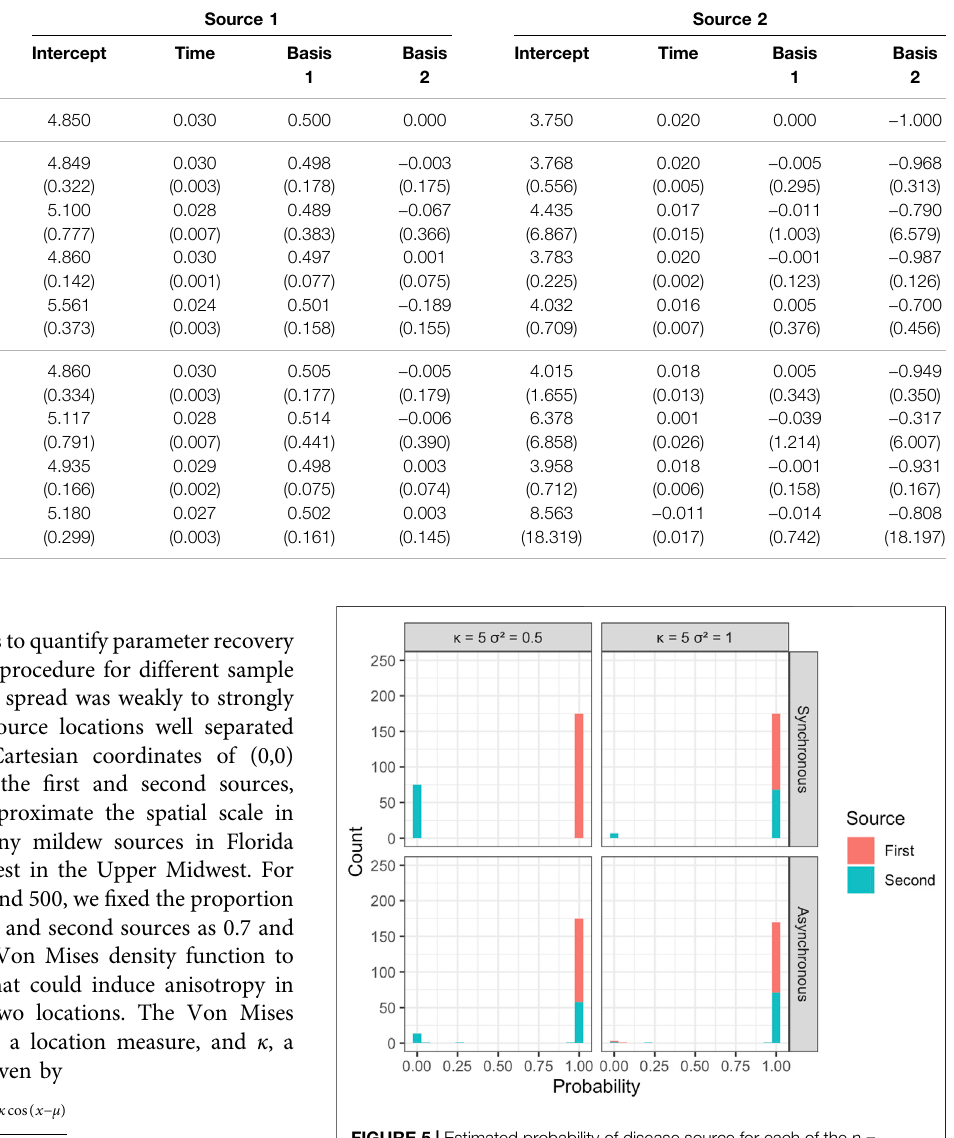
Frontiers in Applied Mathematics and Statistics |